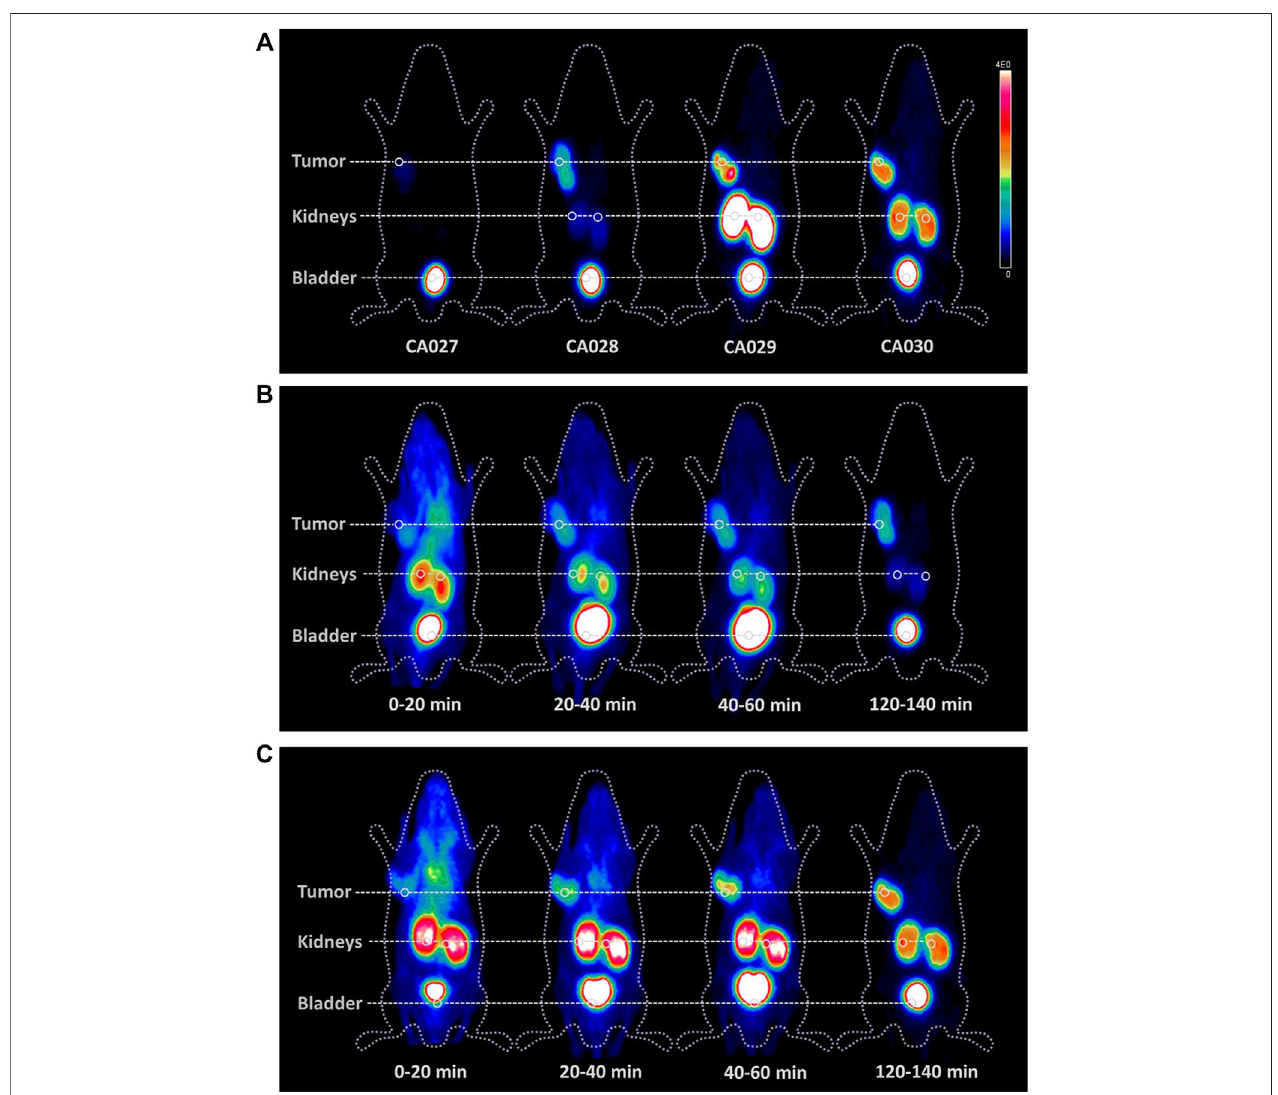
FIGURE 3 | Comparison of whole body small animal PET scans as maximum-intensity projections of BALB/c nude mice bearing C4-2 tumor xenografts. PET imaging of the four new PSMA ligands radiolabeled with 68 Ga (20 MBq; 0.2 nmol) 2 h post injection (A) and the time courses of 68 Ga-CA028 (B) and 68 Ga-CA030 (C) . The color bar gives a link between the SUV and the color scale of the PET image with 0 = minimum and 4E0 = maximum.